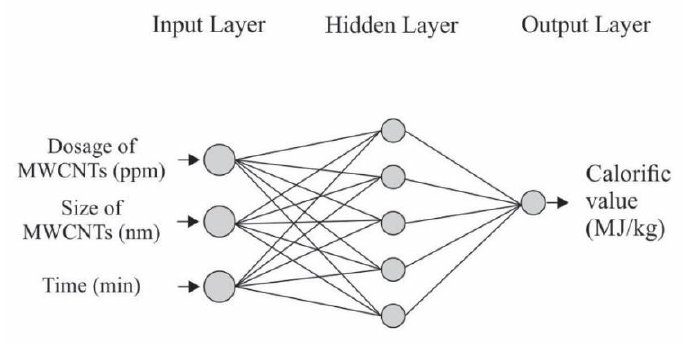
Energies 2019 , 12 , x FOR PEER REVIEW Figure 6. Typical architecture of artificial neural network (ANN). Figure 6. Typical architecture of artificial neural network (ANN).